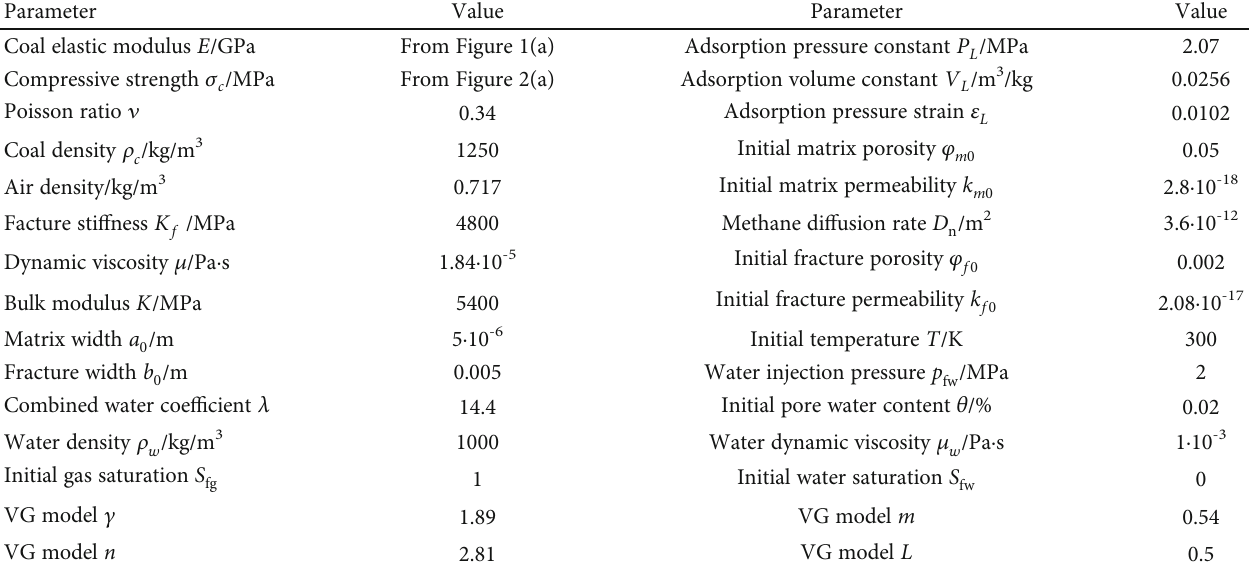
Table 1: Numerical model physical parameters.